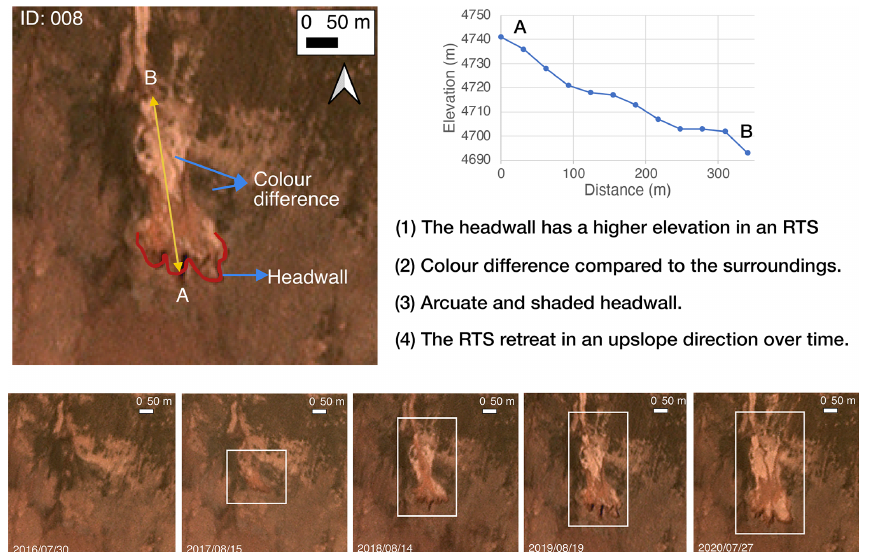
Figure 3. An example of an RTS shown in the PlanetScope image with corresponding criteria illustrated for manual checking. The ID was assigned by us in the inventory. The white polygons highlight the RTS in the images, and this RTS is initialized after August 2016. Basemap data © Planet Labs Inc.